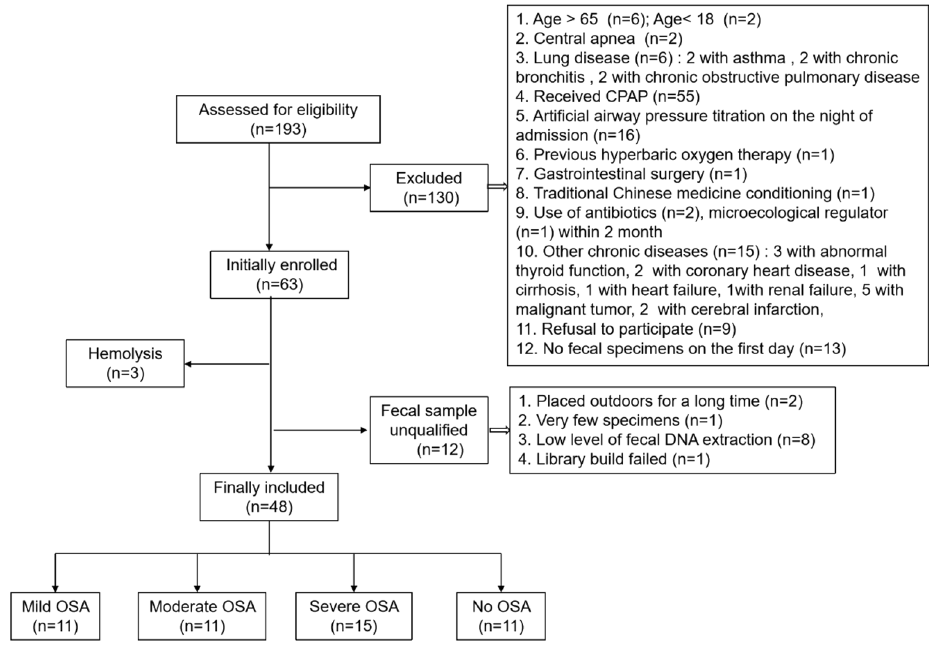
Figure 1. Patient flow